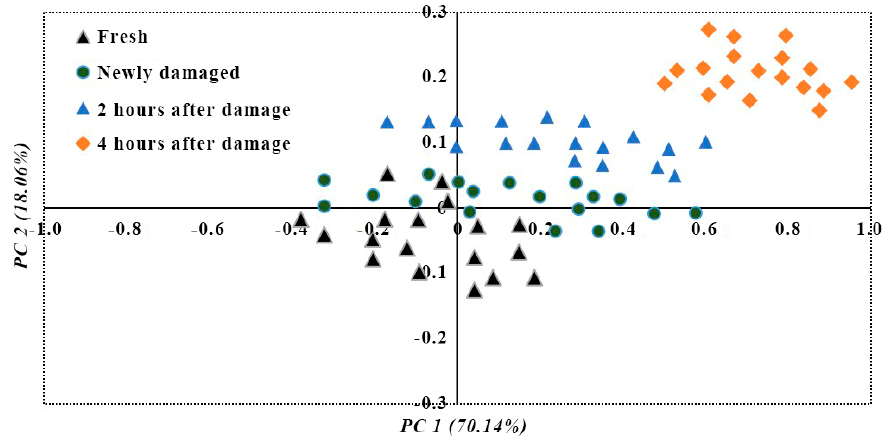
Figure 6. Qualitative analysis of different qualities of litchis by PLS-DA model.